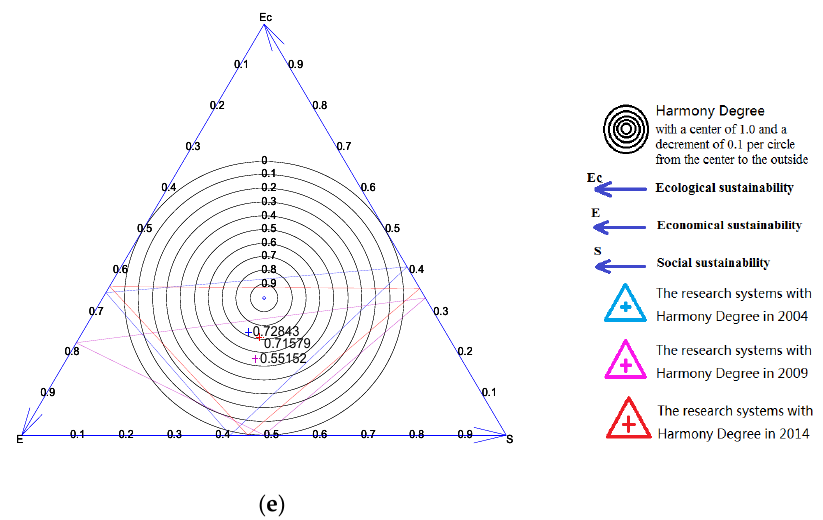
Figure 6. Equilateral triangles depicting the three sustainability subsystems, ecological (Ec), economic (E), and social (S), for Gingko, wheat, and peanut ( a ), Ginkgo, rapeseed, and peanut ( b ), Ginkgo only ( c ), agricultural crops ( d ), and Ginkgo and mulberry ( e ). The internal triangles subscribe the values for each subsystem, and associated crosses are corresponding centroids, the latter of which define the harmony degree (HD). HD values are shown for 2004 (blue cross), 2009 (pink cross), and 2014 (red cross).